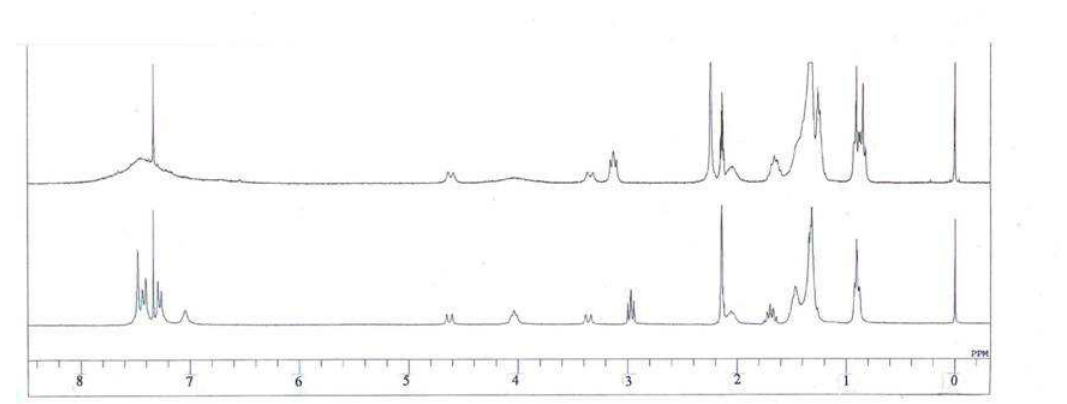
Figure 4. 1 H-NMR spectra of 2b in CDCl CF COOAg (top). 3